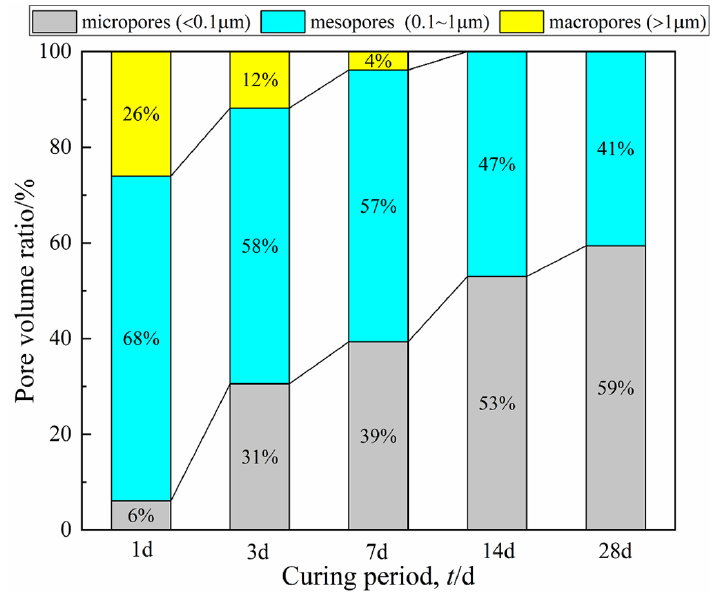
Figure 9. The pore structure evolution of the specimen with 15% cement.